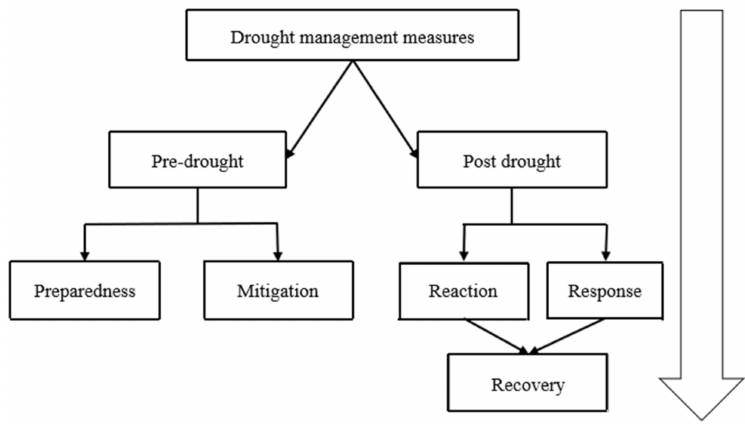
Figure 2. Classification of drought risk management